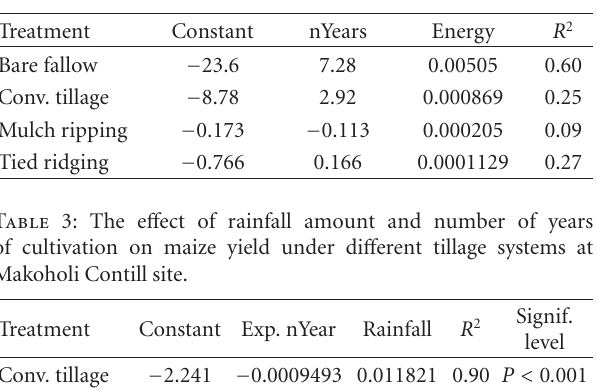
Table 2: The e ff ect of rainfall energy and number of years of cultivation on soil loss under di ff erent tillage systems at Makoholi Contill site.